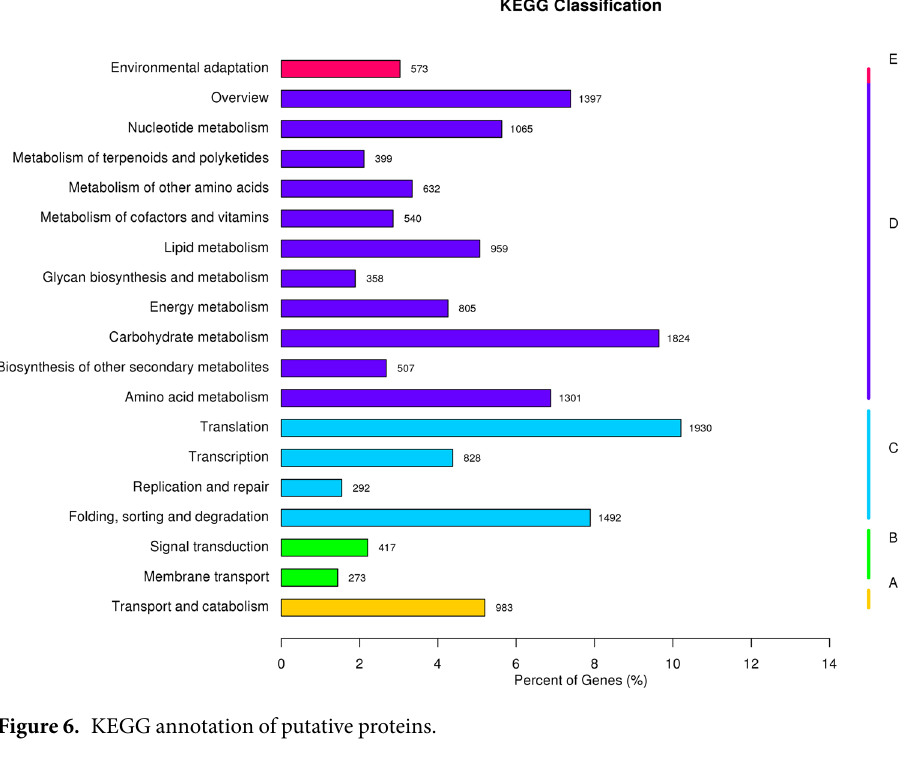
Figure 6. KEGG annotation of putative proteins.